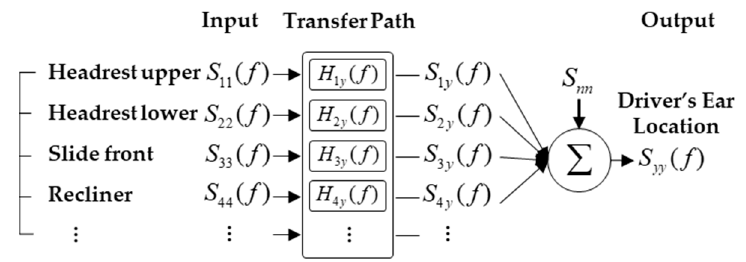
Figure 1. Correlated multiple-input/single-output model.